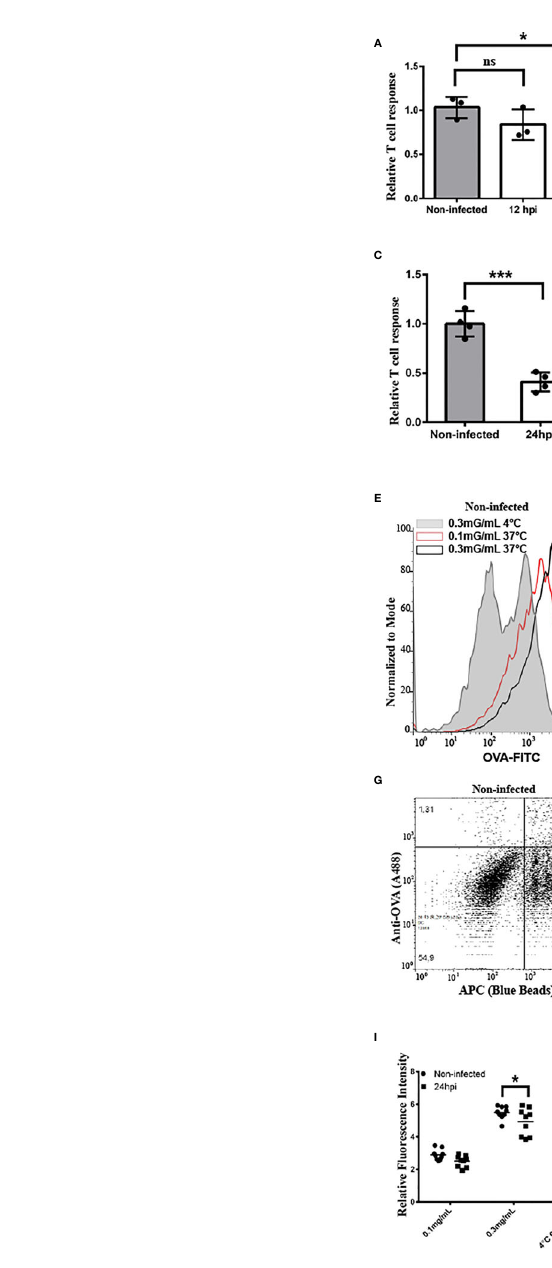
FIGURE 5 | C. trachomatis disturbs antigen cross-presentation by JAWS-II DCs. (A – D) The cross-presentation ability of non-infected and infected JAWS-II DCs with C . trachomatis L2 at MOI 100 after incubation with (A) soluble OVA, (B) OVA/BSA-coated beads, (C) soluble OVA (BMDCs), or (D) the SIINFEKL control peptide at the indicated concentrations was evaluated with the B3Z T cell hybridoma. In (A, D) one-way ANOVA and Bonferroni ’ s multiple comparisons tests were performed. *P < 0.05 and ****P < 0.0001. In (B, C) two-tailed Student ’ s unpaired t-tests were performed *P = 0.0280 (for B ) and ***P = 0.0003 (for C ). Data represent mean ± SEM of three (for A – C ) and four (for D ) independent experiments. (E, F) Non-infected and infected JAWS-II DCs with C. trachomatis L2 for 24 h at MOI 100 were incubated for 1 h with the indicated concentrations of OVA coupled to FITC and fl uid-phase endocytosis was assessed by fl ow cytometry. Effective uptake was performed at 37°C and the highest concentration of OVA at 4°C was used as control. Representative FACS histograms showing the fl uorescence intensity of FITC at the different conditions used in non-infected (E) and infected (F) cells. (G, H) Non-infected and infected JAWS-II DCs with C. trachomatis L2 for 24 h at MOI 100 were incubated during 1, 3, and 5 h with 3 m m fl uorescent latex beads, and the phagocytic capacity was assessed by fl ow cytometry. Phagocytosis was conducted at 37°C for effective uptake and at 4°C for 5 h as control. Representative FACS histograms of the condition 5 h at 37°C showing the APC+/OVA- regions indicate the percentage of internalized particles. (I) Data represent the endocytic uptake and the mean ± SEM of three independent experiments (n = 6). *P < 0.05. Two-way ANOVA and Sidak ’ s multiple comparisons tests were performed. (J) Data represent phagocytosis and the mean ± SEM of three independent experiments (n = 6). ****P < 0.0001. Two-way ANOVA and Sidak ’ s multiple comparisons tests were performed. P-value of NS in (A) is P >